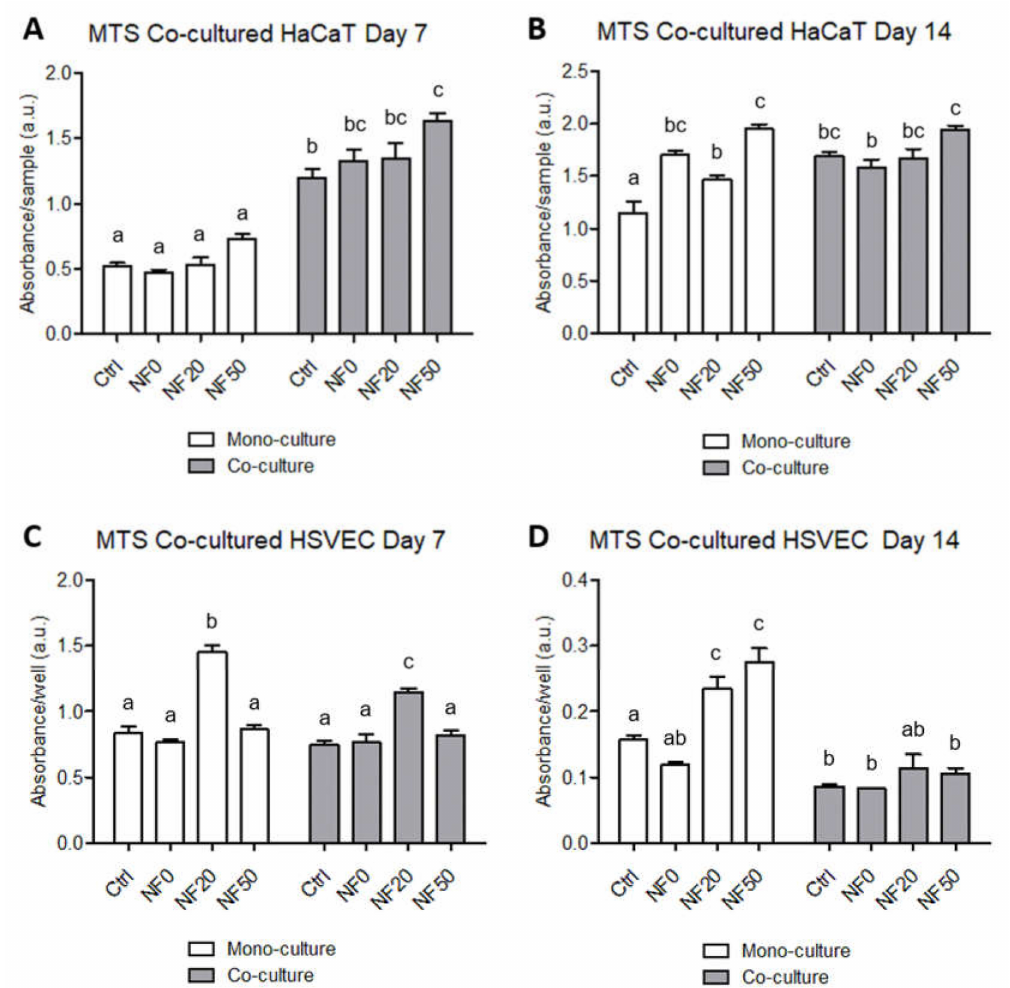
Figure 8. The metabolic activity of the HaCaT and HSVEC in the monocultures and co-cultures of these cell types. The metabolic activity of the HaCaT cells ( A , B ) that grew on the pure NF membranes (Ctrl), and on the NF membranes with fibrin assemblies prepared using various platelet lysate (PL) concentrations, i.e., 0%, 20% and 50% PL (NF0, NF20 and NF50, respectively). The metabolic activity of the human saphenous vein endothelial cells (HSVEC) ( C , D ) that grew on the well bottoms on a polystyrene well plate in the presence of the Ctrl, NF0, NF10, NF20 and NF50 membranes after 7 days ( A , C ) and 14 days ( B , D ) of cultivation. Each graph contains information on the cells that grew in the monoculture (white columns) and those co-cultured with the other cell type (grey columns). The superscript letters above the columns denote significant differences between the NF membranes that do not share the same superscript ( p <